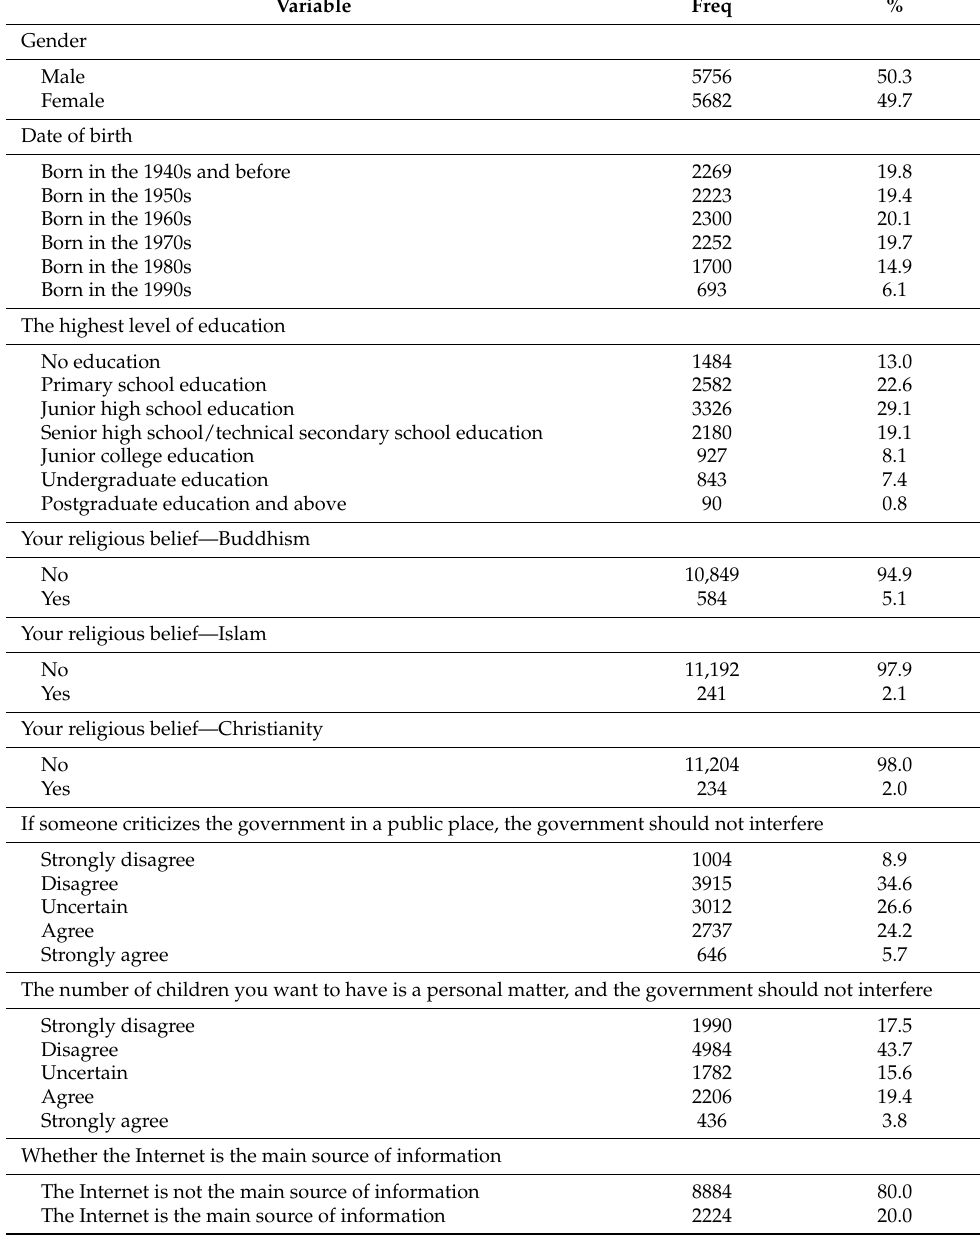
Table 2. Descriptive statistics of